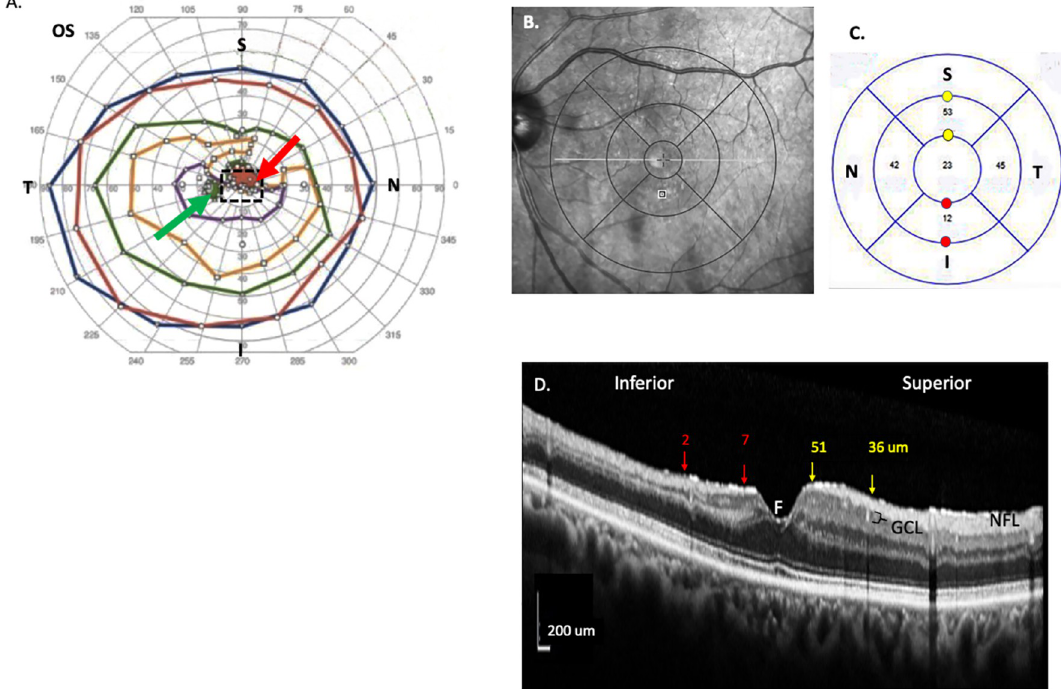
Fig 1. BRAO in 71-year-old BRAO patient. A) Visual field exam. Scotoma immediately above the fovea (red, arrow), perceived in the left eye; the green arow indicates the physiological blind spot. The dotted rectangle shows the relative size of a typical optical coherence tomography (OCT) image used in the present experiment, compared to the much larger visual field circumscribed by the blue line. B) SD-OCT (Heidelberg, Germany) with superimposed ETDRS grid from the left eye of the same patient 91 days after BRAO, with sparsely filled arterioles observed in the inferior arcade. (C) After manual segmentation, average ganglion cell thickness values were thinner in the inner, inferior quadrant (12 μ m) compared to the temporal, superior, and nasal quadrants. The red and yellow circles indicate measuring points on the edges of the 3 mm inner ring corresponding to the red and yellow arrows in the next image. (D) Measurement of the GCL layer with calipers on a photograph of a vertical b-scan. Image was rotated horizontally, stretched vertically, and integrity of the measurement bars maintained. Bracket indicates the GCL layer below the hyperreflective macular nerve fiber layer (NFL). Numbers above are GCL thicknesses at the arrow heads (red = inferior BRAO region; yellow = normal GCL thickness equidistant from the fovea (F) in the superior quadrant). These point values were roughly similar to the quadrant averages in Fig 1C, confirming the validity of segmentation